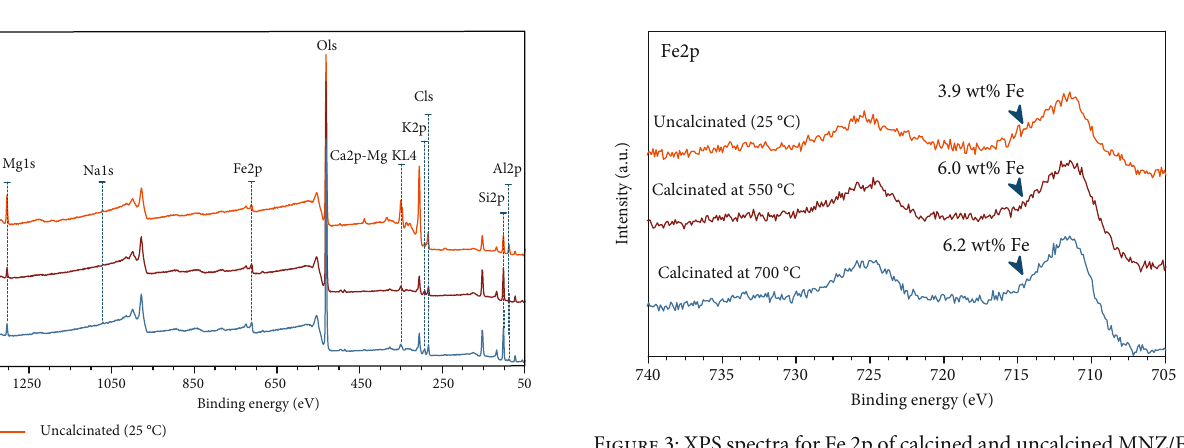
Figure 3: XPS spectra for Fe 2p of calcined and uncalcined MNZ/Fe /g MNZ 3